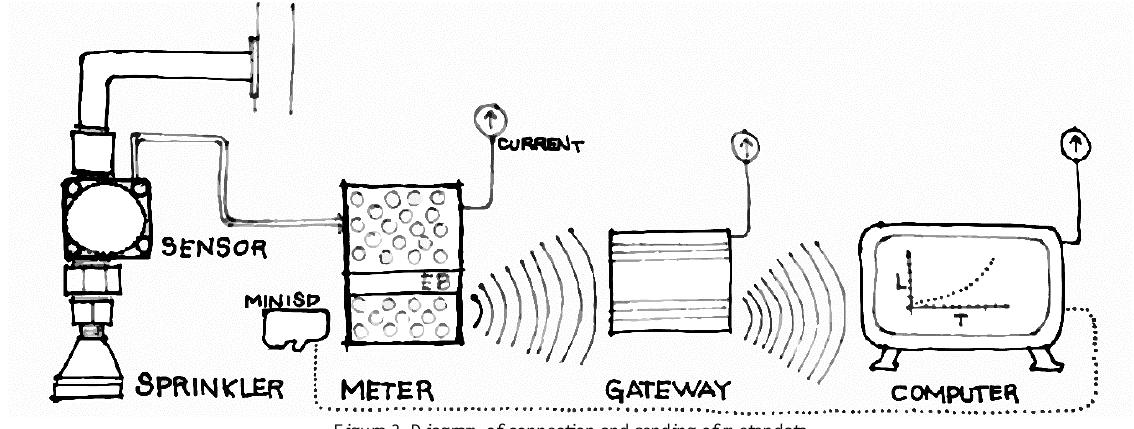
Figure 3. Diagram of connection and sending of meter data